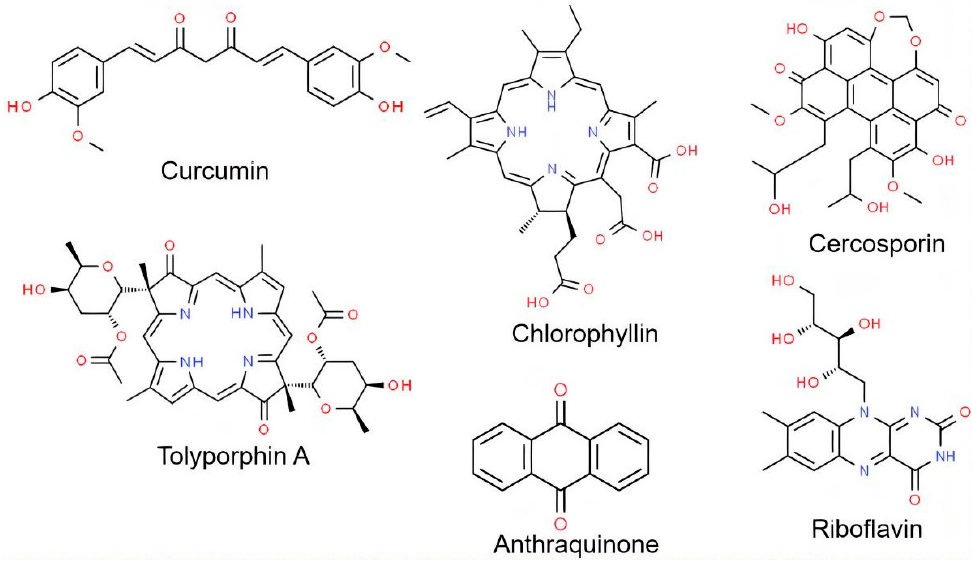
Figure 2. Chemical structure of the main biotechnological photosensitizers applied in PDT. Source: Authors.